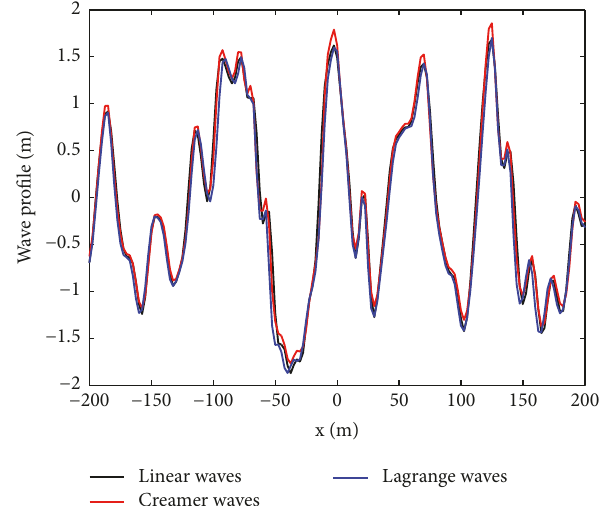
Figure 1: Comparison of linear and nonlinear wave